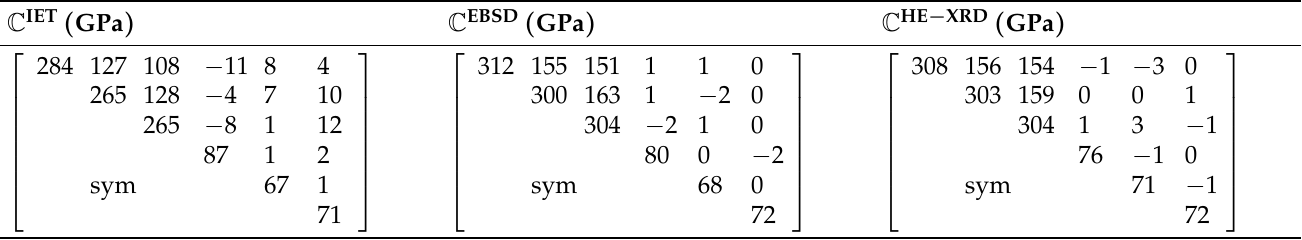
Table 2. Resulting elasticity tensors determined by IET, EBSD and HE-XRD.